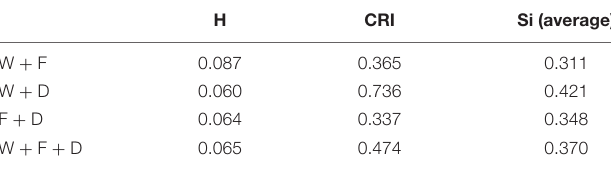
TABLE 5 | Cluster tendency and validation indices for all